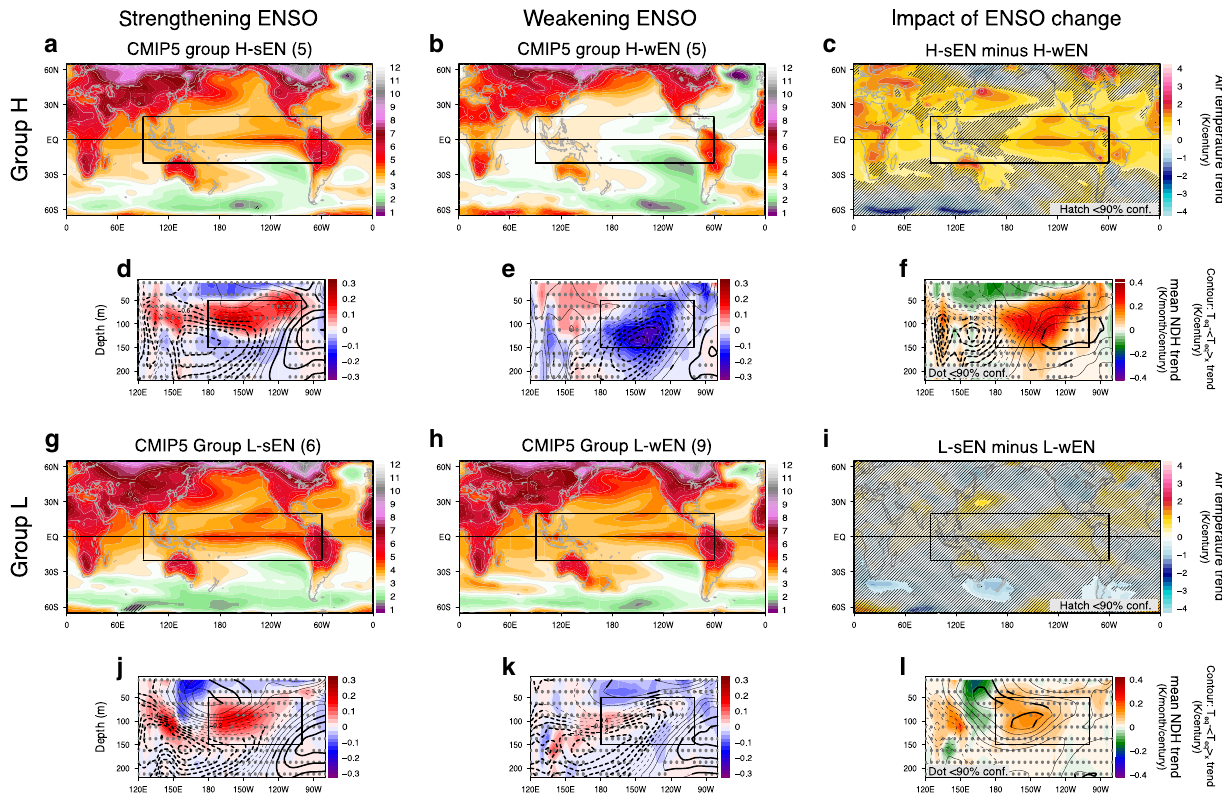
Fig. 7 Surface warming due to ENSO amplitude change. a – f Linear trends of the near-surface air temperature ( a – c ) and equatorial nonlinear dynamical heating (NDH) ( d – f ) in groups H-sEN and H-wEN and their difference (H-sEN minus H-wEN) in the CMIP5 Representative Concentration Pathway 8.5 scenario simulations. In d – f the contours show the departure of temperature trend for 1°S – 1°N from its Paci fi c zonal mean between 120°E and 80°W. g – l As in ( a – f ) but for groups L-sEN and L-wEN. Hatched and dotted areas over shading indicate that the values are not statistically signi fi cant at the 90% con fi dence level. Thick contours indicate statistically signi fi cant values at the 90% con fi dence level. Solid boxes represent the regions for the El Niño- likeness calculation of the warming trend and the NDH